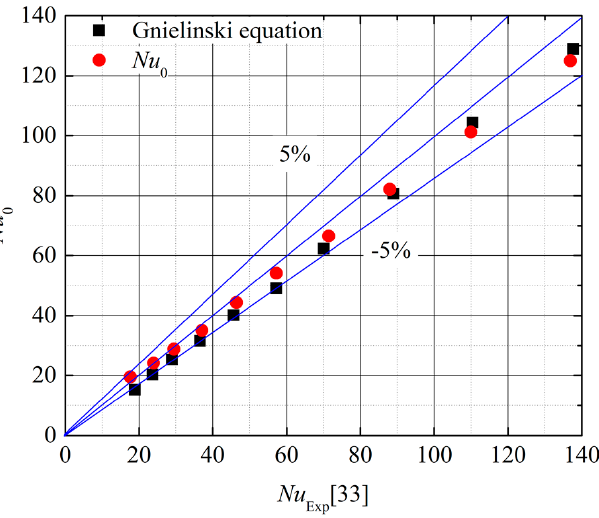
Figure 8. Comparisons of numerical results of Nusselt number with the date from Gnielinski [33] correlation.